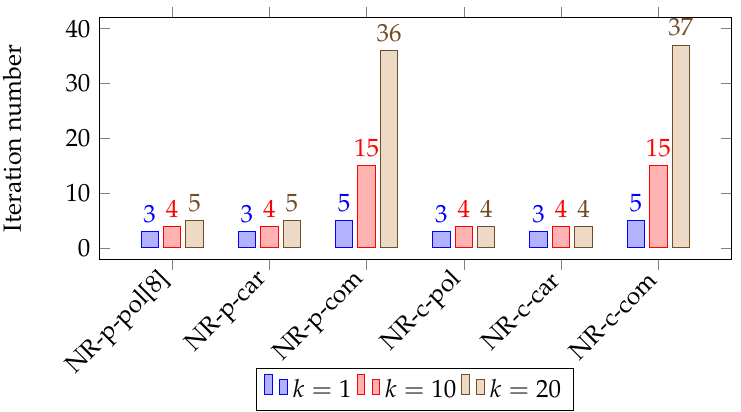
Figure 8. Convergence results for different loading conditions ( S = k ∗ S ) in